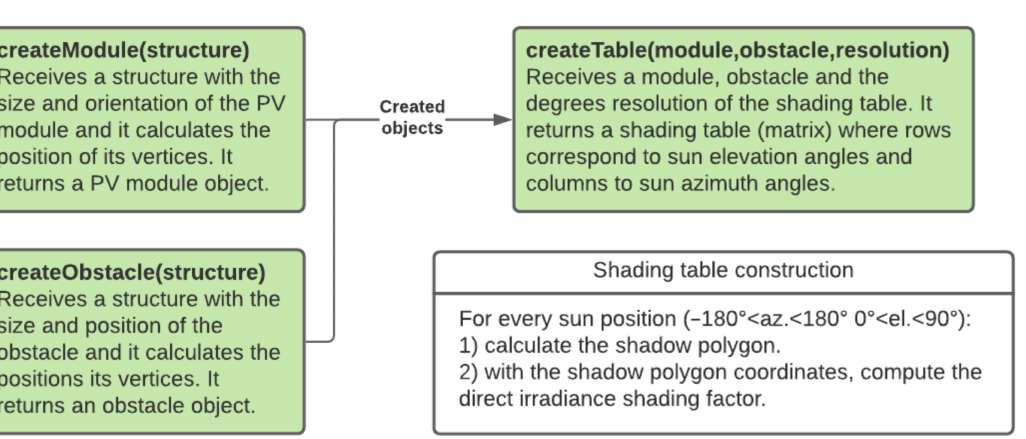
Figure 1. The classes createModule and createObstacle are used for creating the PV module and obstacle objects. The objects contain the geometry of the given situation. The class createTable receives the module, obstacle, and the angle resolution of the sun elevation and azimuth angles. Finally, the class returns a shading table